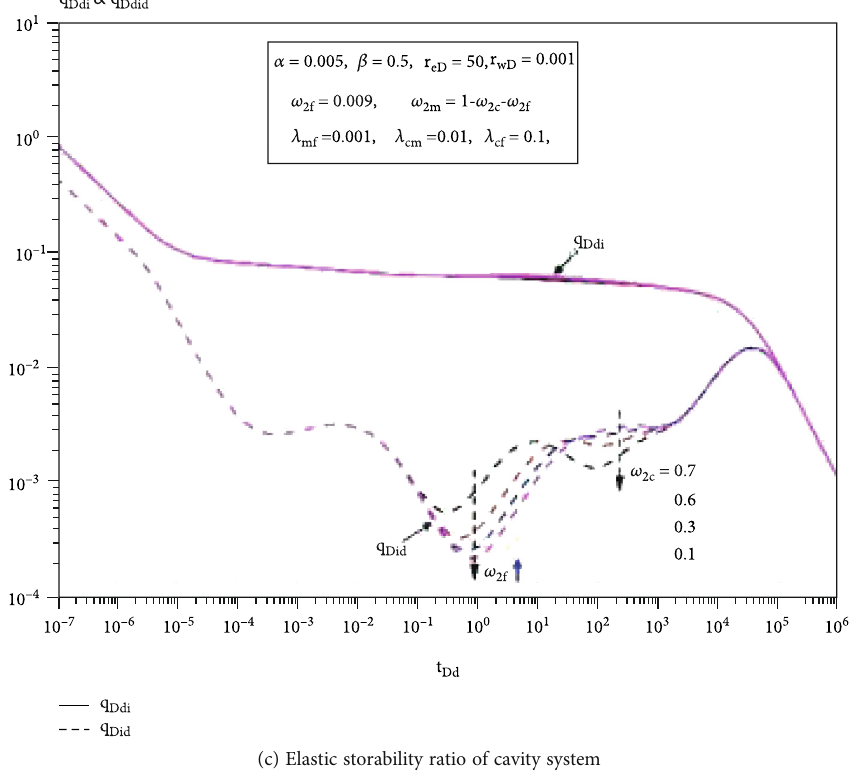
Figure 13: New rate decline curves of an AFVW in a pore-cavity-fracture carbonate reservoir under di ff erent elastic storability